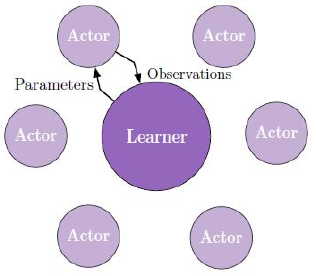
Figure 5. IMPALA single learner model.